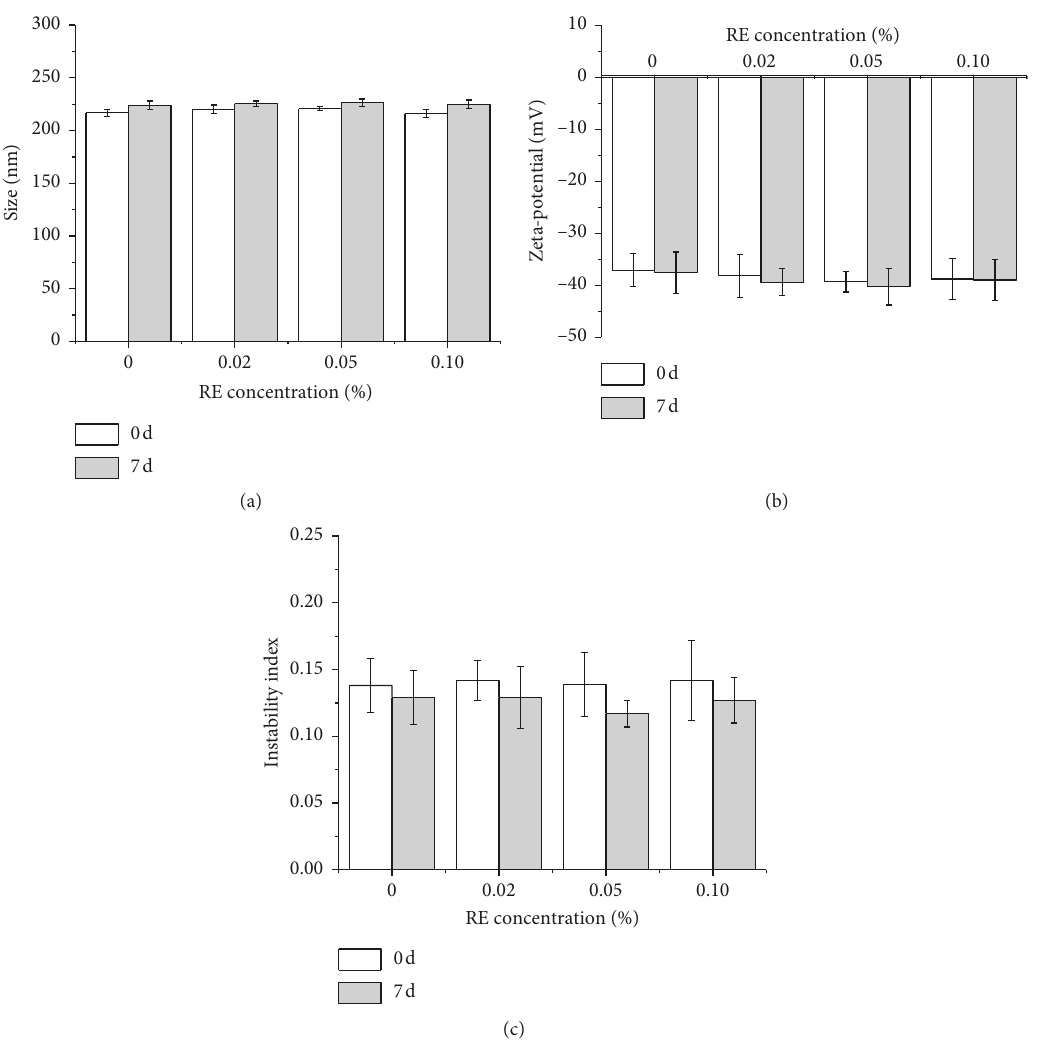
Figure 1: Effect of the different concentrations of rosemary extract (RE) (in the oil phase) on the droplet size (a), zeta-potential (b), and instability index (c) of WPI-stabilized lutein emulsion before storage (0 days) and after storage (7 days) at 55 ° C. Data points represent means ( n � 3) ± standard